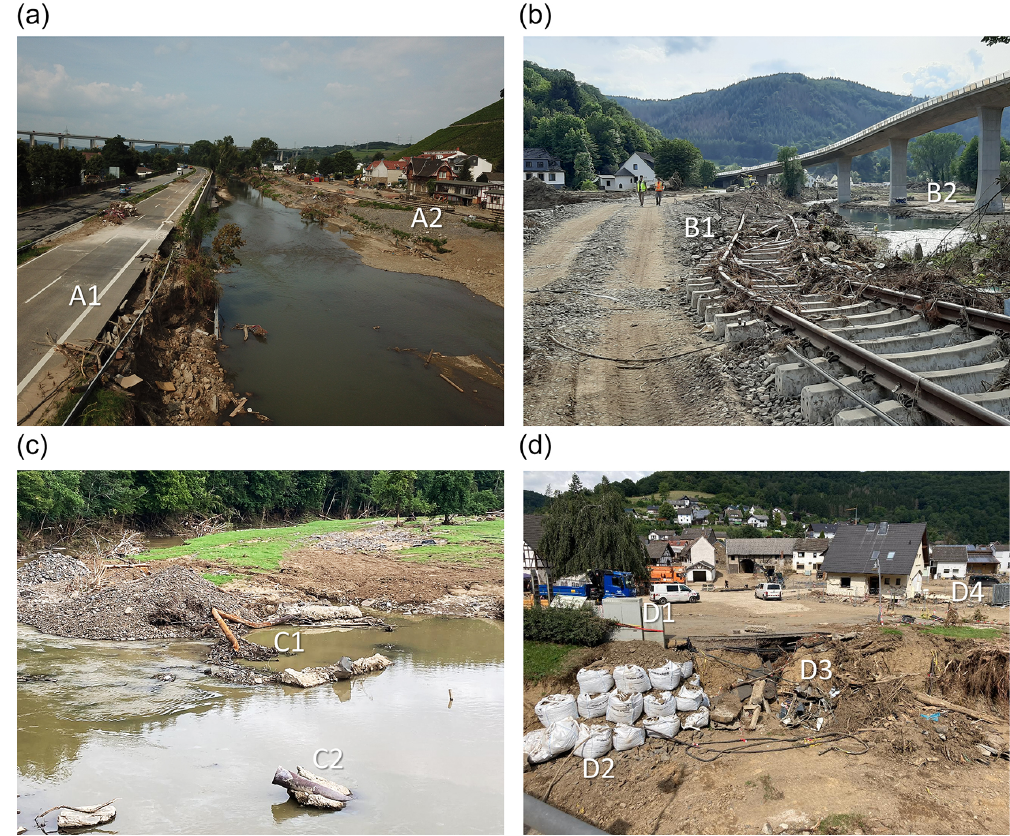
Figure 1. Damage in the Ahr valley, Germany (images taken on 11 August 2021). (a) Destruction of federal highway B266 (A1) and railway (A2) near Heimersheim. (b) Further upstream in the Ahr valley (Altenburg), large stretches of the Ahrtalbahn railway have been destroyed (B1) and the few remaining road and rail bridges show signs of temporary repairs (B2). (c) Riverbed erosion uncovered and destroyed many cables supposed to lie more than 80cm below surface level (C1) as well as sewers (C2). (d) Inundated electricity dis- tribution infrastructure (D1), road erosion and stabilization (D2), uncovered cables (D3), and collapsed buildings in Schuld. Pictures by Margreet van Marle/Deltares/GEERassociation, distributed under Creative Commons Attribution 4.0